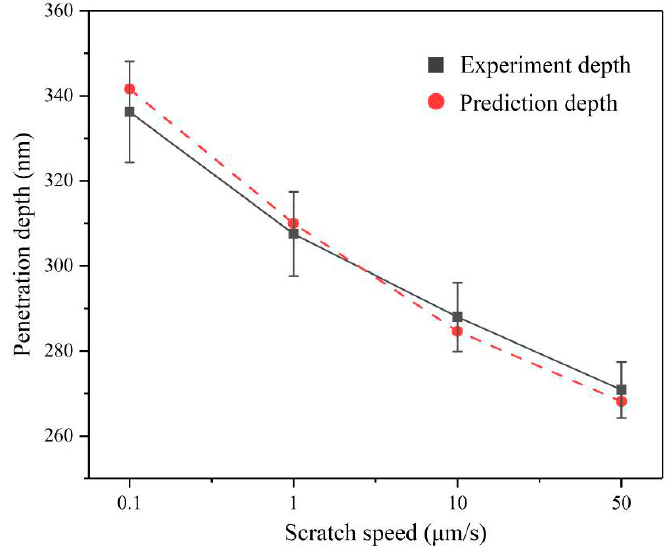
Figure 11. Prediction depths and experiment penetration depths at different scratch speeds.